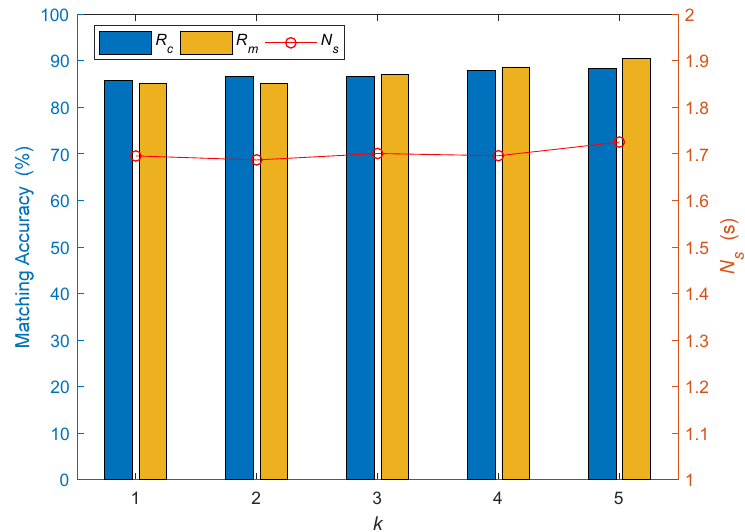
Figure 11. Matching results under different candidate values for k .